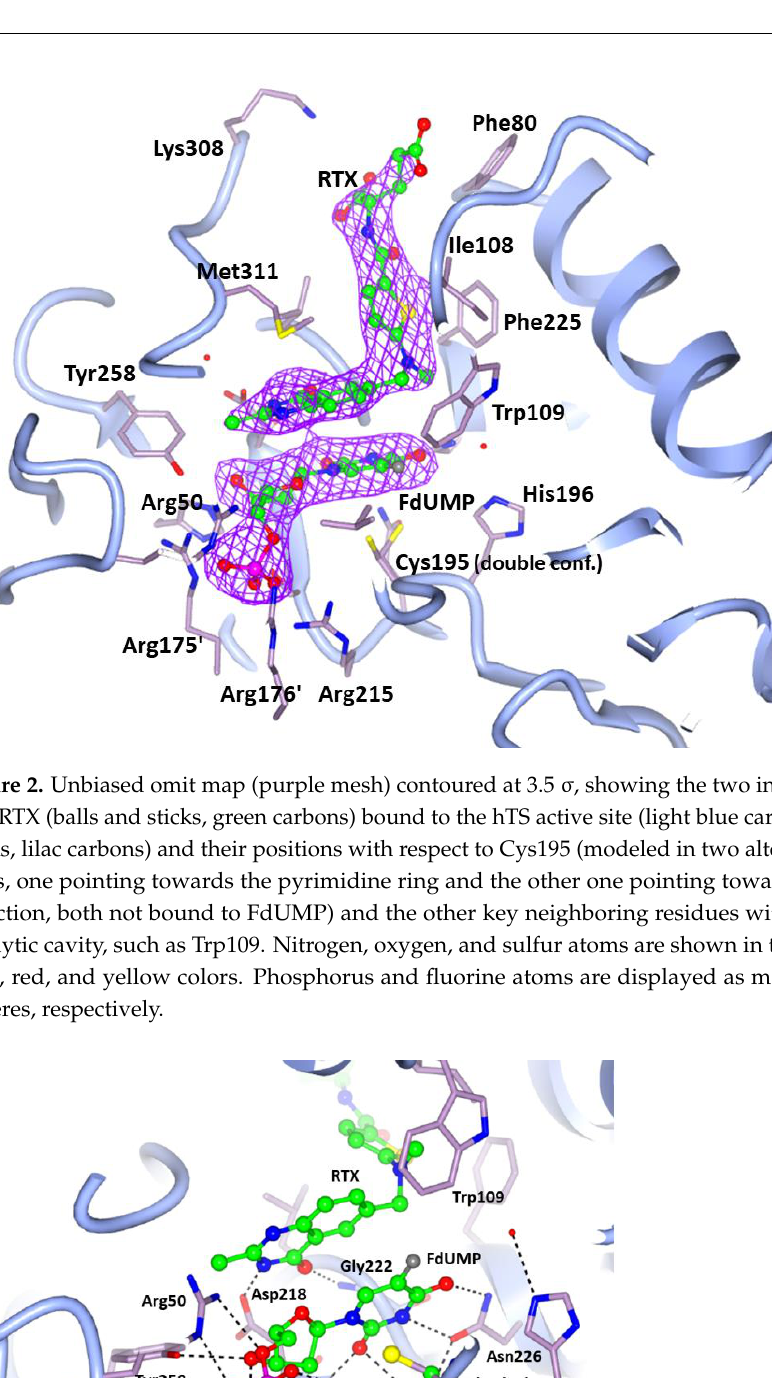
6 of 19 Figure 1. ( a ) Least-squares superposition of hTS in the active (light cyan ribbons; hTS:FdUMP:RTX complex, PDB id: 6ZXO) and inactive (light gold ribbons, PDB id: 3N5G [33]) conformations. The structured loop (residues 181–197) is shown as either a dark cyan or a dark gold rope for the active and inactive conformer, respectively. The different orientations of the catalytic Cys195 residues, represented as balls and sticks, can be appreciated. When the 181–197 loop is in the active confor- mation, loop 107–128 is structured (cyan rope) whereas it is disordered, thus not visible, when loop 181–197 is in the inactive conformation. The FdUMP and RTX molecules, bound to the “closed” active site, are represented as balls and sticks (green carbons). Oxygen atoms are colored red, nitro- gen blue, sulfur yellow, phosphorous magenta, and fluorine gray. ( b ) Chemical structures of RTX and FdUMP. In the latter, the loop formed by residues 181–197 adopts a conformation in which the catalytic Cys195 lies out of the active site (dark gold in Figure 1). When the 181–197 loop is in the inactive conformation, loop 107–128 is normally disordered and never visible in the elec- tron density maps. When the 181–197 loop is in the active conformation (dark cyan in Figure 1), with Cys195 pointing into the active site, the 107–128 loop (cyan in Figure 1) becomes or- dered and fully visible in the maps. The present crystal structure of the hTS:FdUMP:RTX com- plex shows six independent enzyme subunits arranged in three homodimers in the triclinic unit cell. All six subunits are in the active conformation and host in the active site one FdUMP